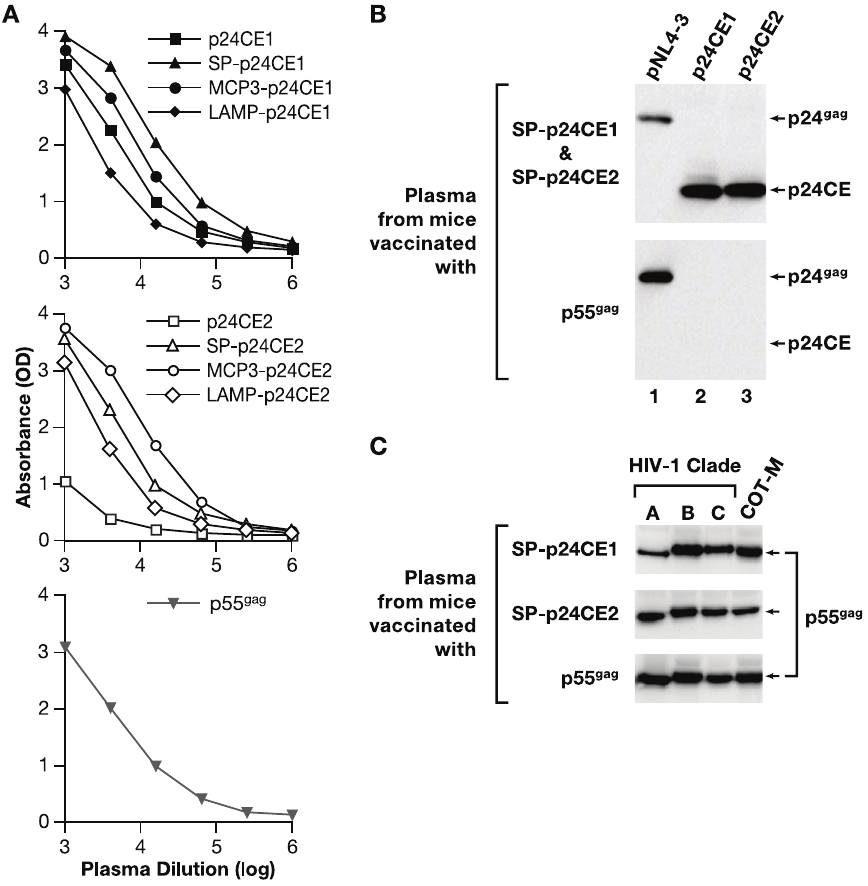
Figure 6. Humoral immune responses in p24CE DNA vaccinated mice. ( A ) Anti-HIV-1 p24 gag antibodies were measured in plasma from p24CE and p55 gag DNA vaccinated C57BL/6 mice by a standard clade B p24 gag ELISA. The graphs show absorbance (optical density, OD) and pooled plasma samples dilutions from mice vaccinated with the different p24CE1 plasmids (top panel), p24CE2 plasmids (middle panel), or p55 gag DNA (bottom panel). ( B ) Humoral responses induced upon SP-p24CE or p55 gag DNA vaccination in mice were analyzed by Western immunoblot assays. The membranes contain p24 gag protein collected from supernatants of HEK293 cells transfected with 5 m g of the infectious molecular clone pNL4-3 (lane 1) or the p24CE proteins collected from the cell-associated fractions of cells transfected with SP-p24CE1 and SP-p24CE2 plasmids (lanes 2 and 3, respectively). The membranes were probed with plasma (1:5000 dilution) from mice vaccinated with a mixture of SP-p24CE1&2 DNAs (top panel) or p55 gag DNA (bottom panel) followed by anti-mouse IgG-HRP labeled antibody and visualized by ECL. ( C ) Detection of humoral responses to full- length p55 gag in mice vaccinated with p24CE or p55 gag DNA by Western immunoblot assay. The p55 gag proteins were obtained from HEK293 cells transfected with 0.5 m g of RNA/codon optimized plasmids expressing unprocessed p55 gag from clades A, B and C or COT-M, respectively. The proteins were resolved on 10% NuPAGE Bis-Tris gels, and the membranes were probed with plasma (dilution 1:200) from mice immunized with DNAs expressing the secreted p24CE proteins SP-p24CE1 (top panel), SP-p24CE2 (middle panel) and p55 gag (bottom